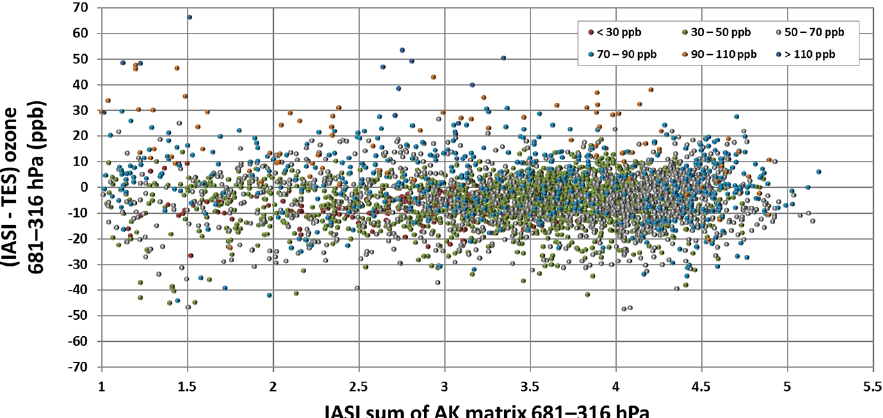
Figure 2. Differences between IASI-TOE and TES 681–316hPa average ozone mixing ratio as a function of the sum of the IASI-TOE AK matrix in the same pressure range. The markers’ colour represents IASI-TOE ozone mixing ratio bins as annotated in the legend. The offset between IASI-TOE and TES neither depends on the measurement sensitivity nor the ozone mixing